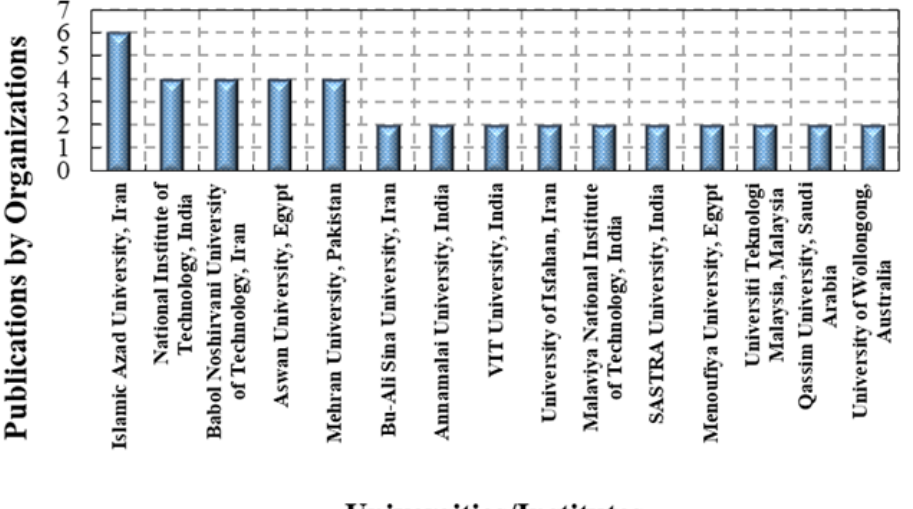
Figure 5. Organizations (universities/institutes) with the most publications in the field of simultane- ous DG-SCB allocation in distribution networks.